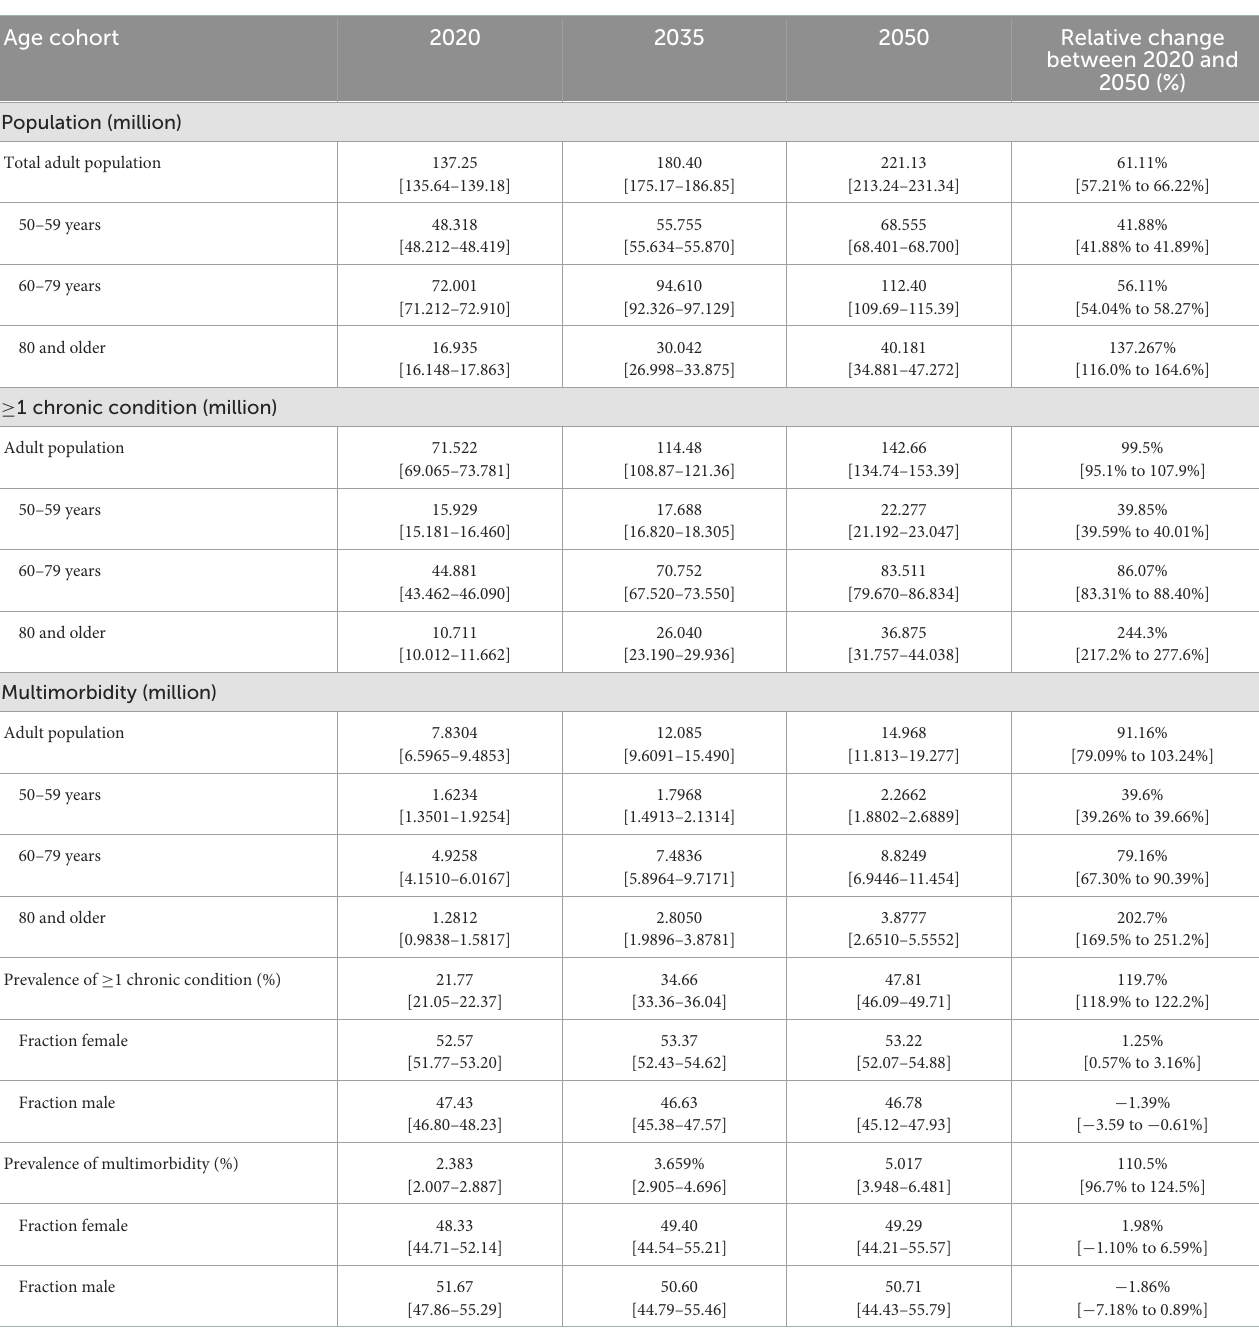
TABLE 1 Projected number of adults 50 years and older with chronic disease in the United